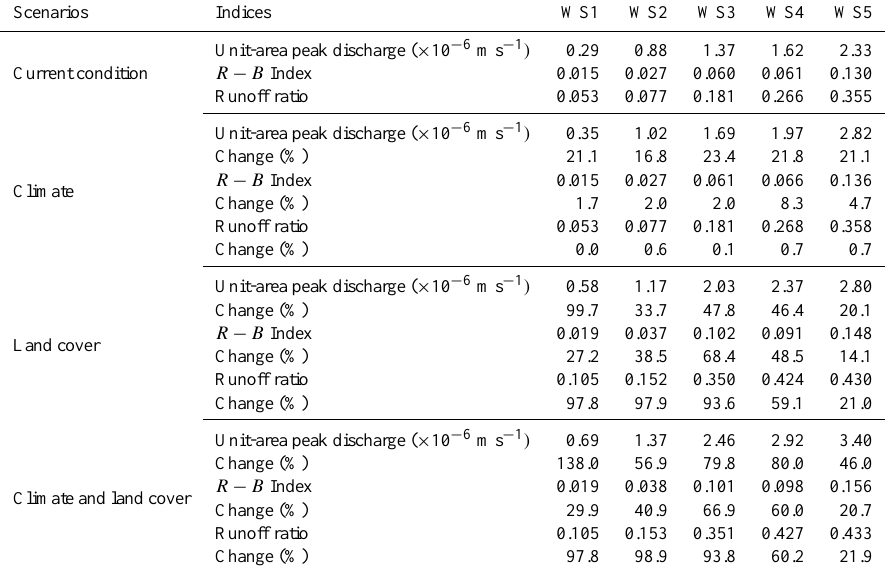
Table 4. Hydrological response characteristics for current condition, climate change, land cover change, and combined scenarios for five watersheds (WS1 to WS5) in central Iowa. The relative changes in percent for climate, land cover and combined scenarios are calculated compared to the current